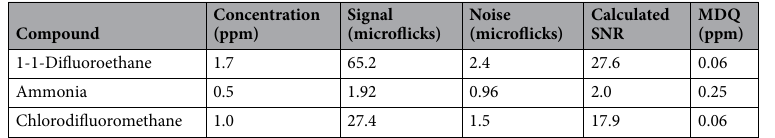
Table 3. Minimum Detectable Quantities of Target